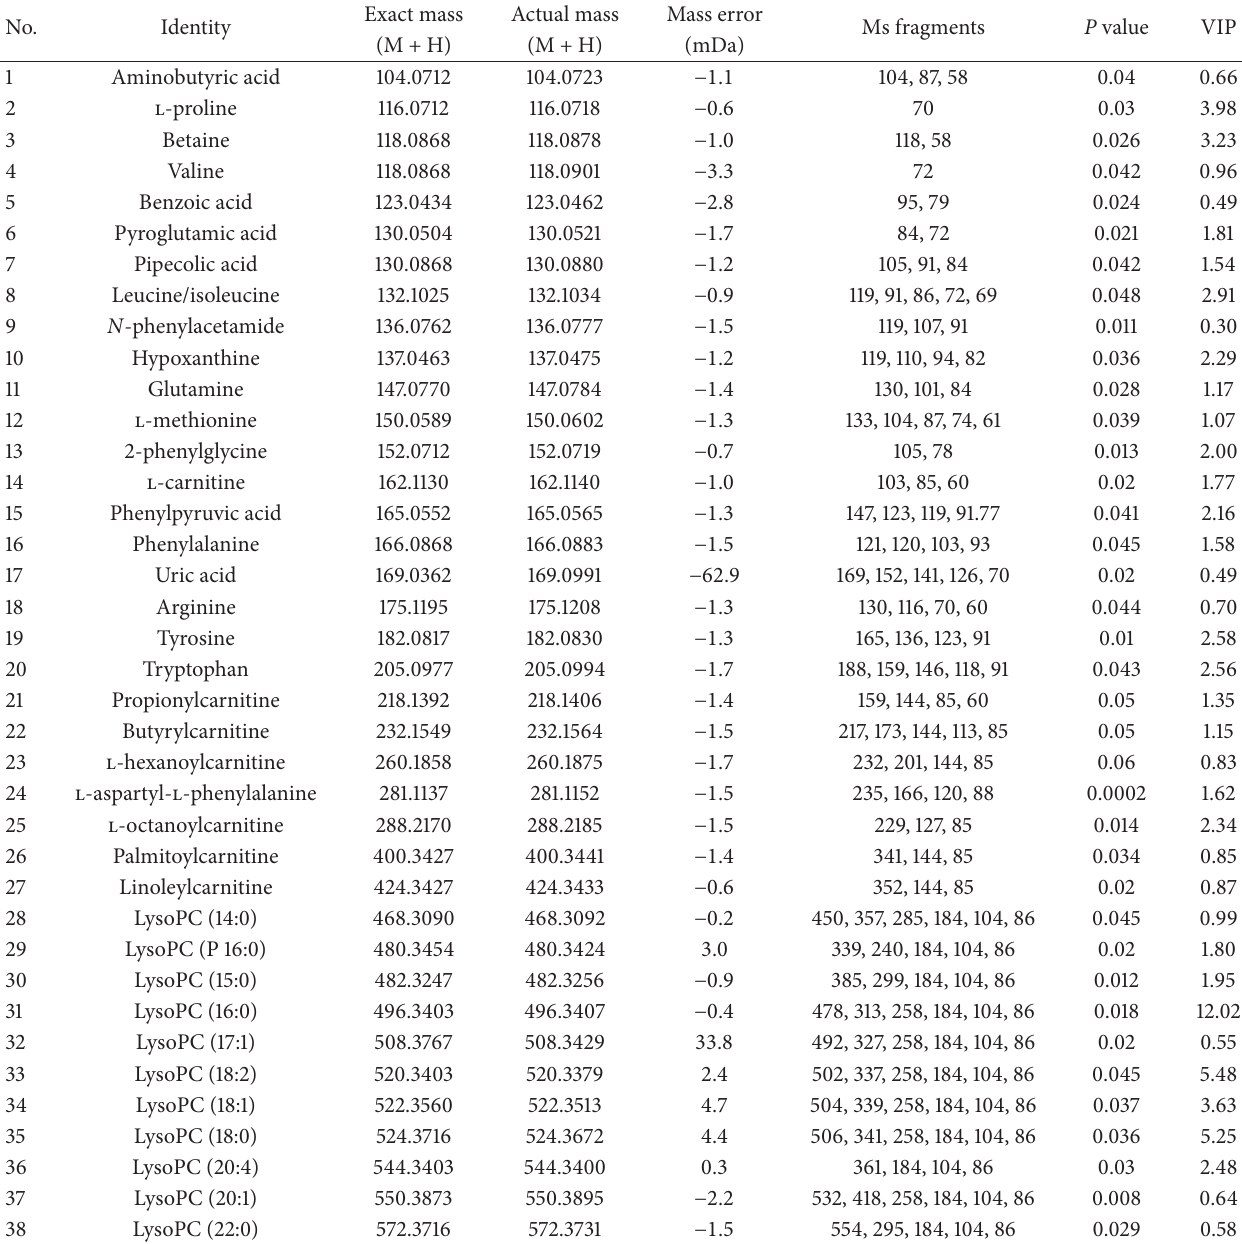
Table 2: Identification of serum metabolites from human subjects controlled by obesity with BSP using UPLC-MS and their fold change analysis.